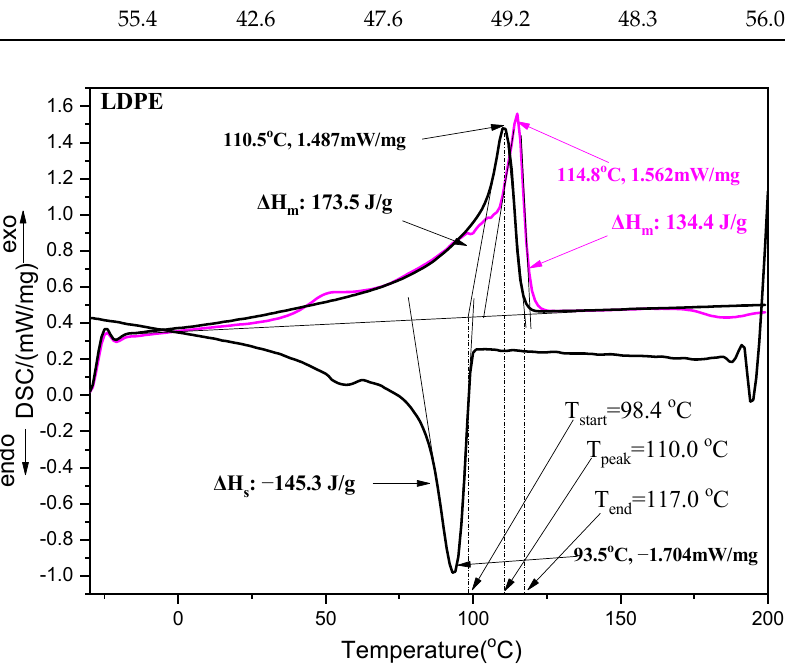
Figure 8. DSC plot of pure LDPE following a standard method saved in the library of the DSC214 Polyma instrument. The pink line is the first melting process (melting 1st step), the black downward line is the sequential crystallization process (crystallization 2nd step), and the black upward line is the last melting process (melting 3rd step). Table 1. Calculated values of enthalpies ( Δ H), temperatures (T start , T peak, T end ), and degree of crystallinity (%Xc) for the melting 1, melting 2, and crystallization processes of all LDPE/xNZ and LDPE/15TO@NZ films, as well as pure LDPE film for comparison.